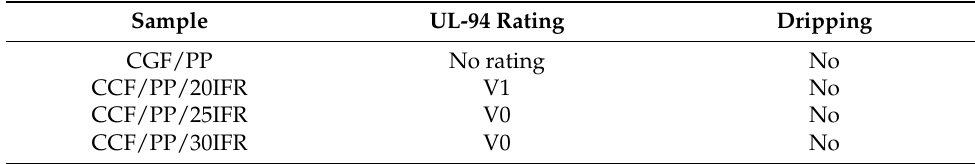
Figure 4. The LOI of samples with different content of IFR. Table 3. UL-94 results of CGF/PP and CGF/PP/IFR samples.